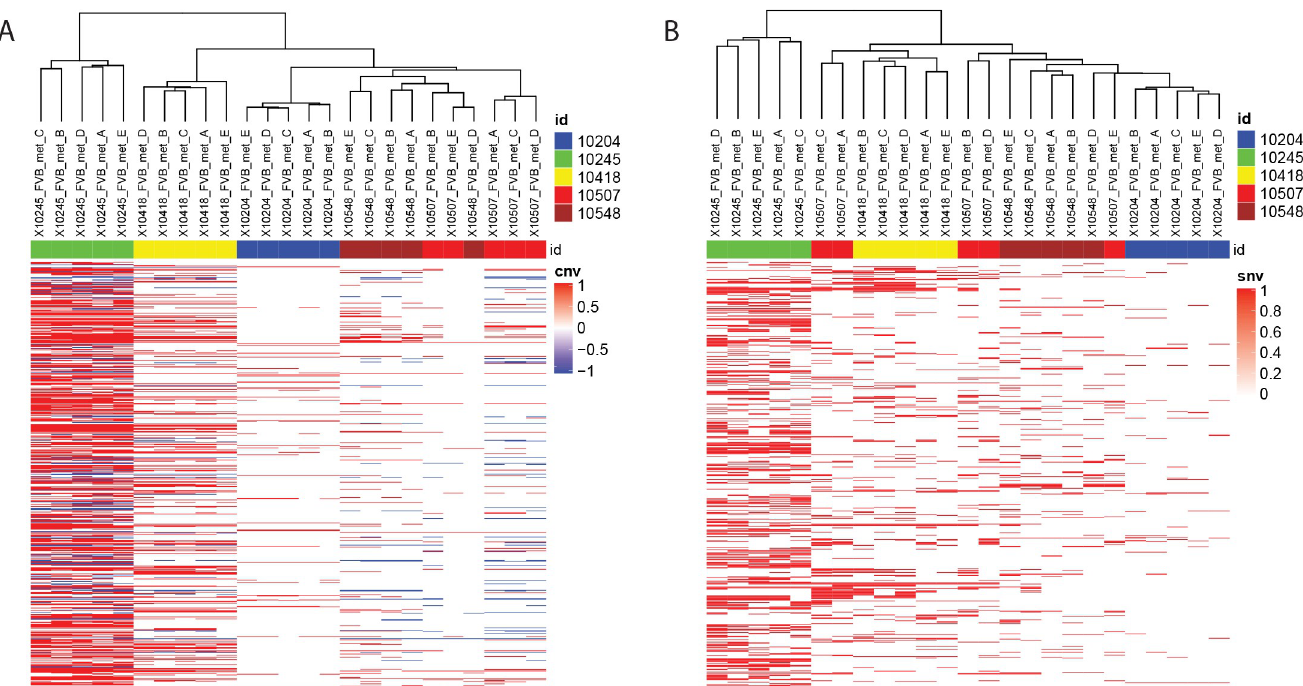
Fig 5. Metastases can originate from multiple primary tumour subclones. Heat maps for hierarchical clustering of genomic a. CNV and b. SNV fingerprints from five metastases isolated from five mice and compared to matched primary tumors. Chromosomes are represented along the Y axis, and sample names across the X axis. Colored bands across the top of the heatmap indicate mouse ID (Blue: 10204, Green: 10245, Yellow: 10418, Red: 10507, burgundy: 10548). Within the heat maps, red indicates amplification ( A ), or presence of an SNV ( B ), and blue indicates a deletion ( A ).